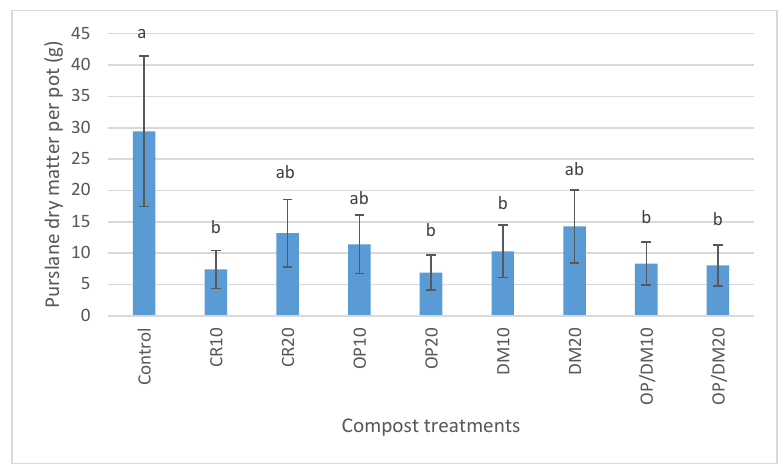
Figure 8. Purslane dry matter production per pot as affected by different compost sources and rates. Error bars represent ± standard error ( P = 0.006, n = 6). Bars sharing the same letter are not statistically different according to Tukey’s HSD test (at P < 0.05).